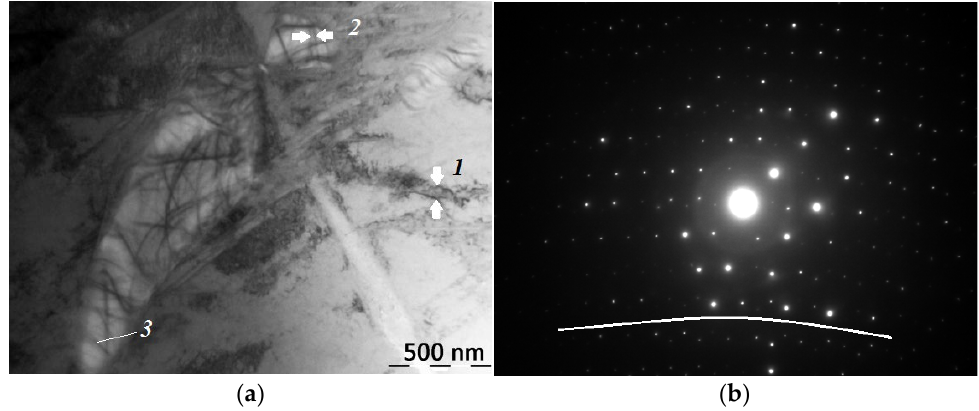
Figure 2. Investigation of the crack tip in a thinned Ni 51 Ti 49 sample subjected to cryomechanical treatment in liquid nitrogen: ( a ) image obtained in a transmission electron microscope, ( b ) electronogram of this site.